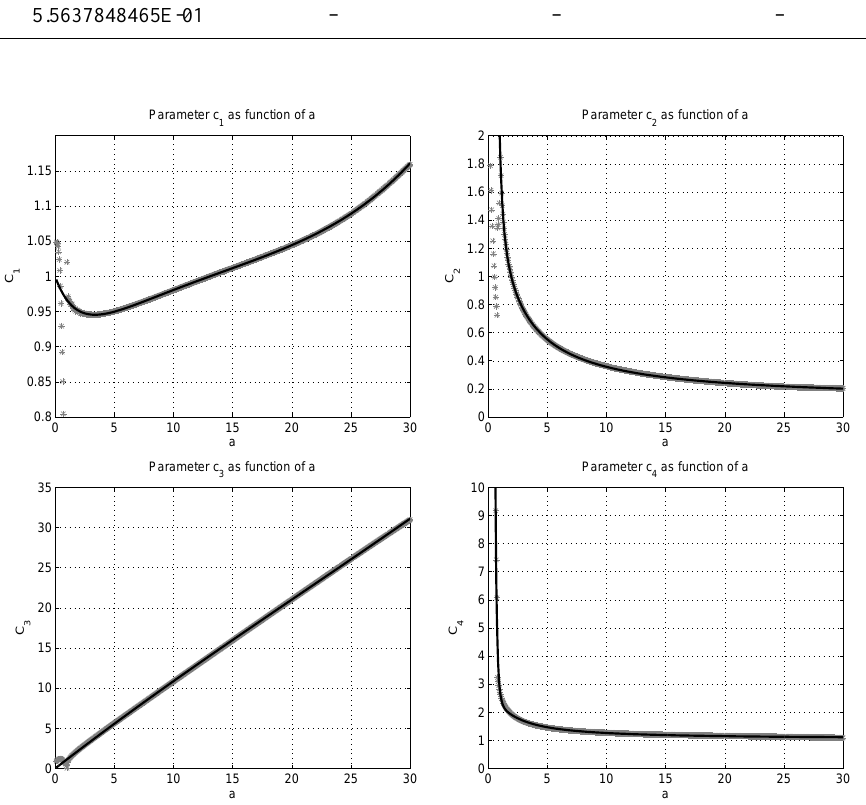
Fig. 3. Numerical values (grey stars) of the regression coefficients c 1 through c 4 in Eq. (12) as derived by nonlinear regression for fixed values of a . Black lines: nonlinear regression functions to each of c 1 through c 4 as functions of a after ansatz (14) and the coefficients from Table 1.